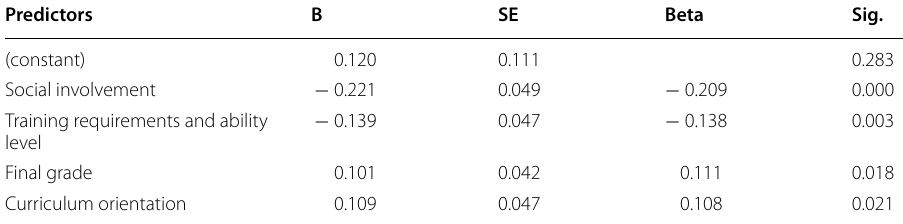
Table 3 Narrow model 1: regression model on drop-out intention downwards